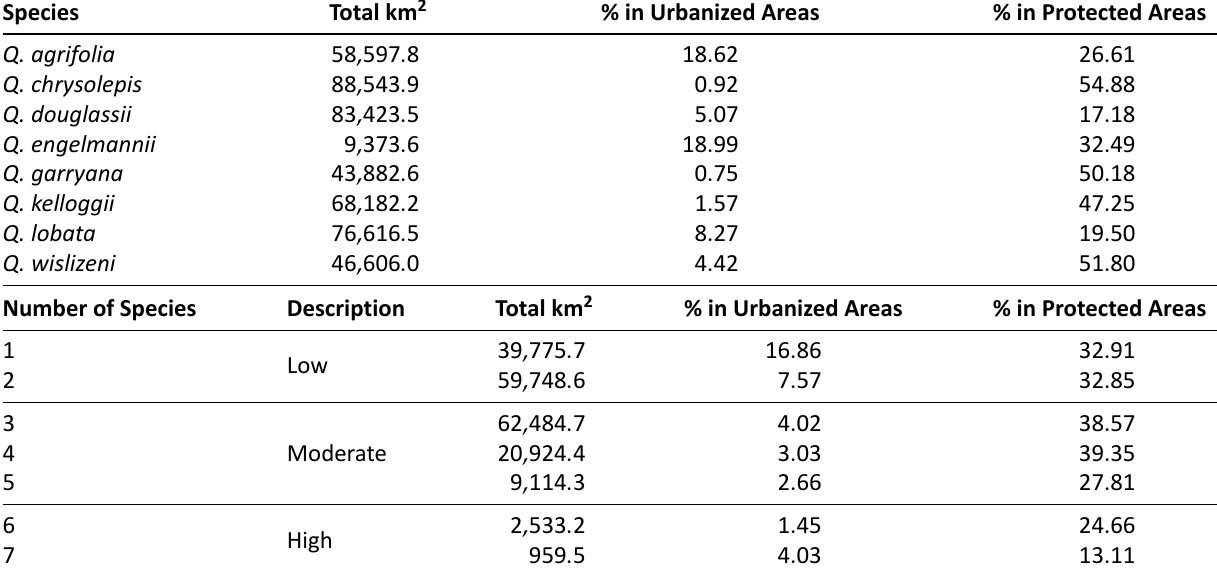
Table 3. Modeled Historical Oak Richness. Area supporting oaks predicted to occur based on species distribution models, by number of oak tree species richness and individual oak species, and the percentage found within urban or protected